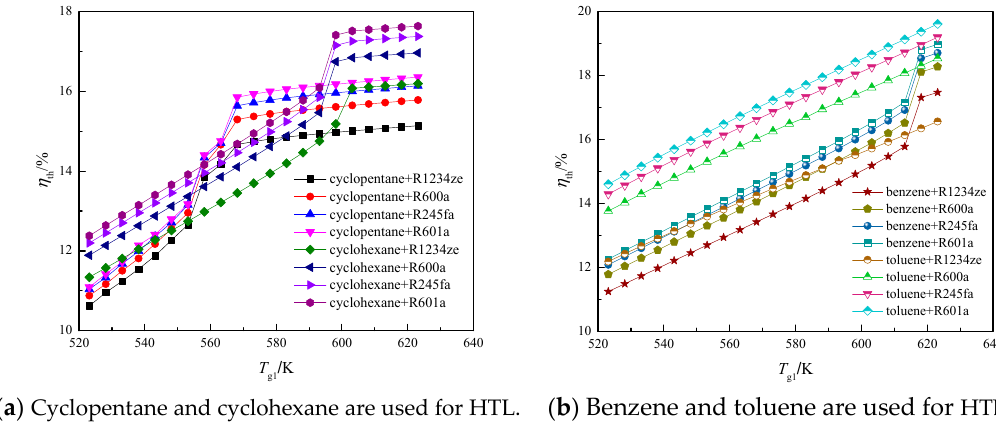
Figure 6. Effects of T g1 on the thermal efficiency.